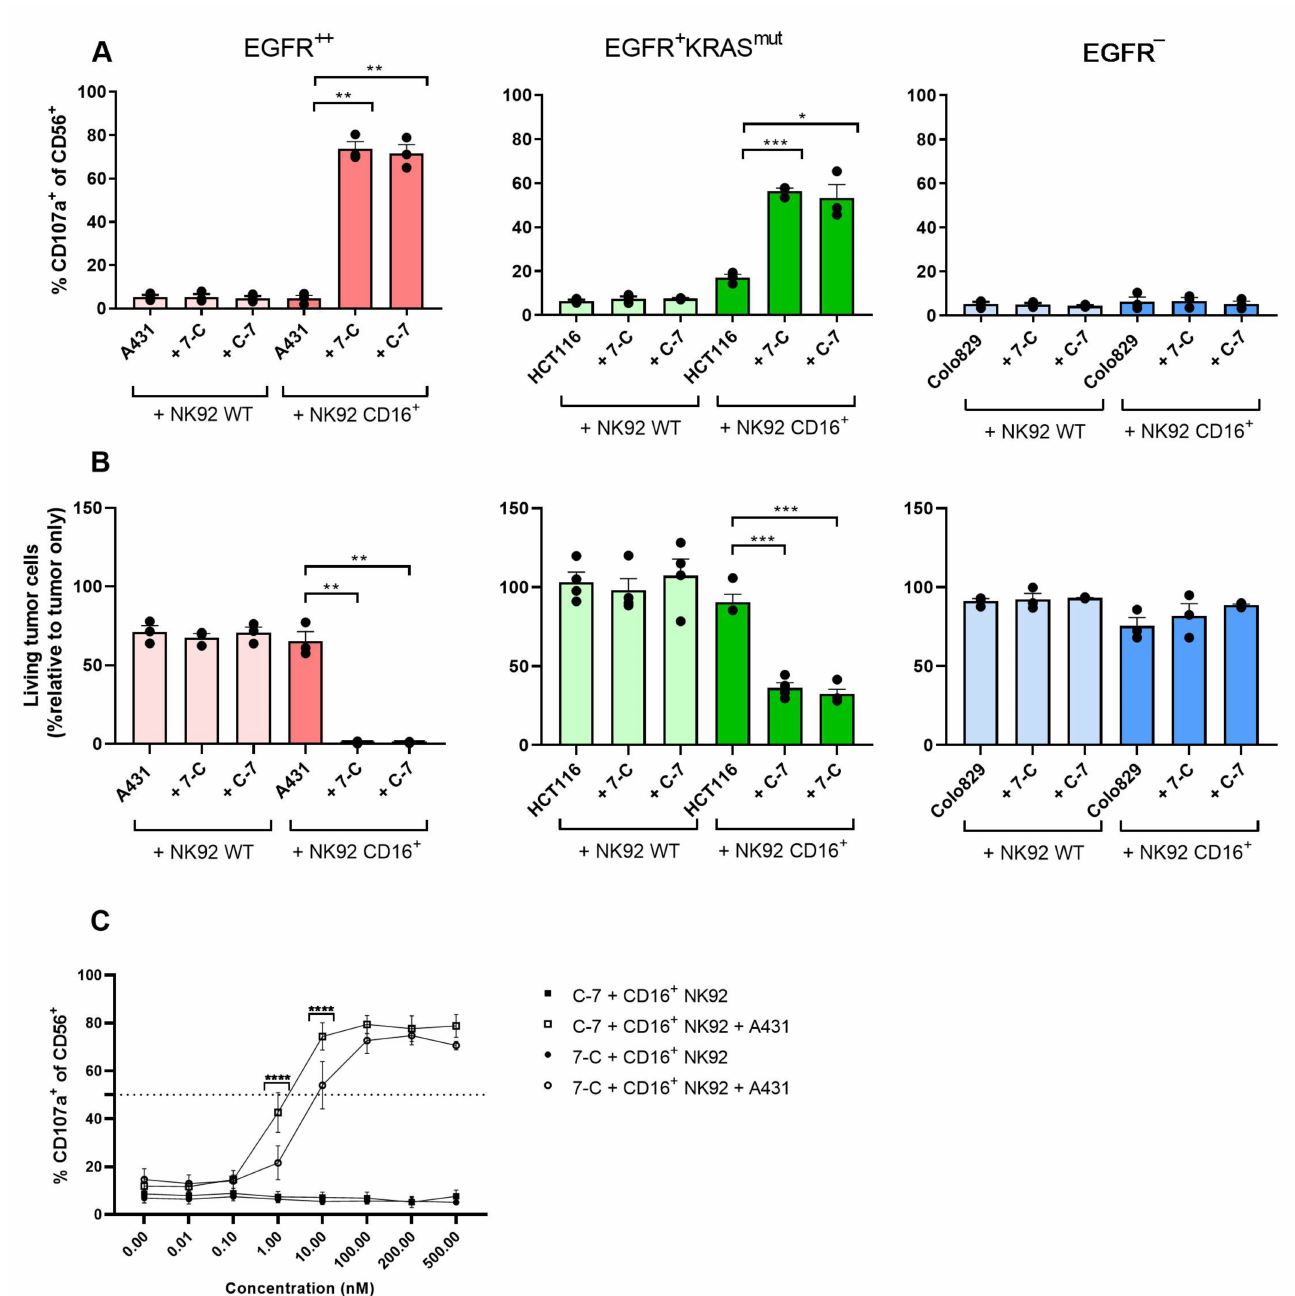
Figure 4. CD16-EGFR bispecific VHHs induce degranulation of CD16 + NK92 cells and cytotoxicity against EGFR-expressing tumor cells. Degranulation ( A ) and cytotoxicity ( B ) of NK92 WT and NK92 CD16 + co-cultured ± 100 nM bispecific VHHs ± tumor cell lines expressing different levels of EGFR: A431 (EGFR ++ ), HCT116 (EGFR + RAS mut ), Colo829 (EGFR − ). Degranulation was determined after 4 h by assessing the percentage of CD107a + cells. Cytotoxicity was determined after 24 h by assessing the relative percentage of living tumor cells compared to the tumor-alone condition. E:T ratio: 1:1. The bars represent mean ± SEM. A431 n = 3 ( A , B ); HCT116 n = 3 ( A ) and n = 4 ( B ); Colo829 n = 3 ( A , B ). ( C ) Degranulation of NK92 CD16 + after 4-h co-culture with A431 ± concentration range of the bispecific VHHs. Degranulation was assessed by determining the percentage of CD107a + cells. E:T ratio: 1:1. The data are presented as mean ± SEM. n = 4. Significance is presented as p < 0.05 *, <0.01 **, <0.001 ***, <0.0001 ****. p -values were determined by two-tailed paired t -test ( A , B ) or with two-way ANOVA with Bonferroni multiple comparison analysis (C). Abbreviations: C-7 = C21-7D12 bispecific VHH, 7-C = 7D12-C21 bispecific